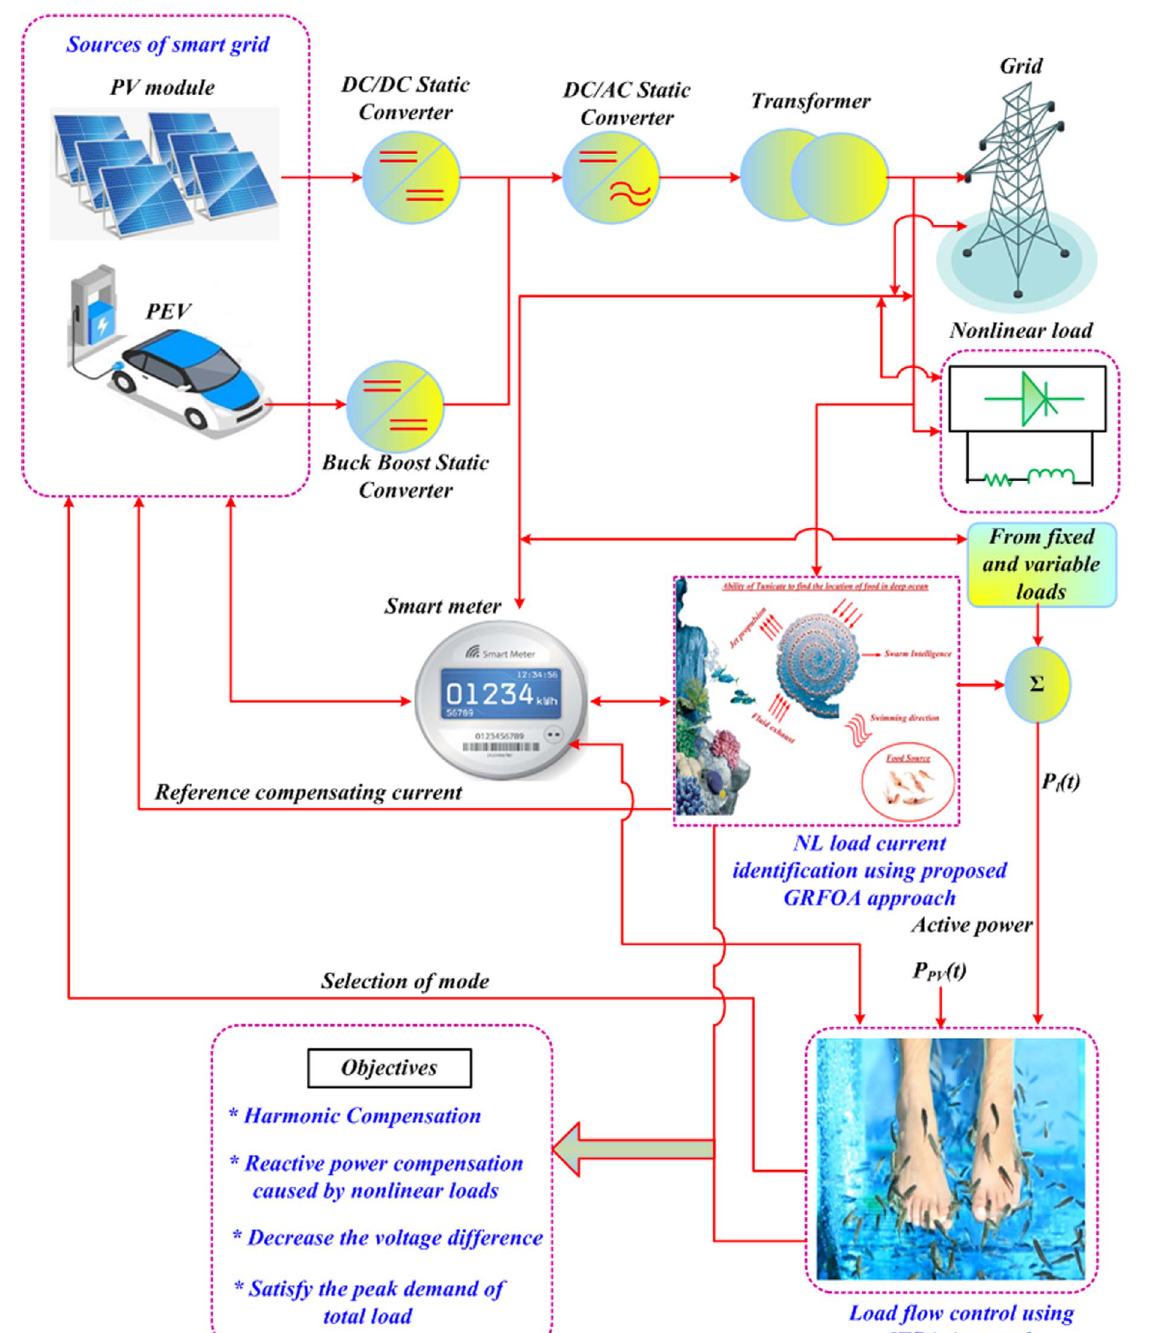
Figure 1. Con fi guration of integrated PV and PEV system with proposed